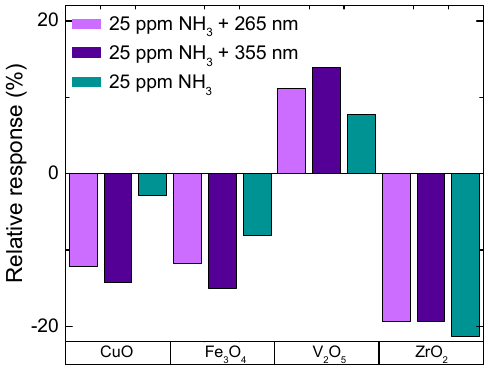
Figure 5. Relative responses of NL DEG sensors vs. 25 ppm of NH 3 at 50% RH, without and with UV irradiation, based on [27].